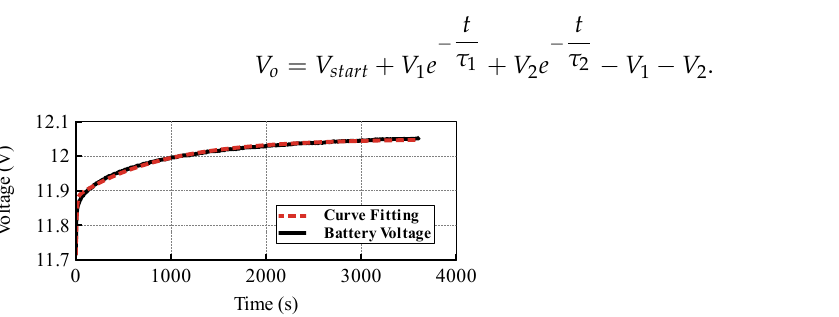
Figure 6. Curve Fitting performed to estimate the time constants of the 2RC Thevenin model for the SLA